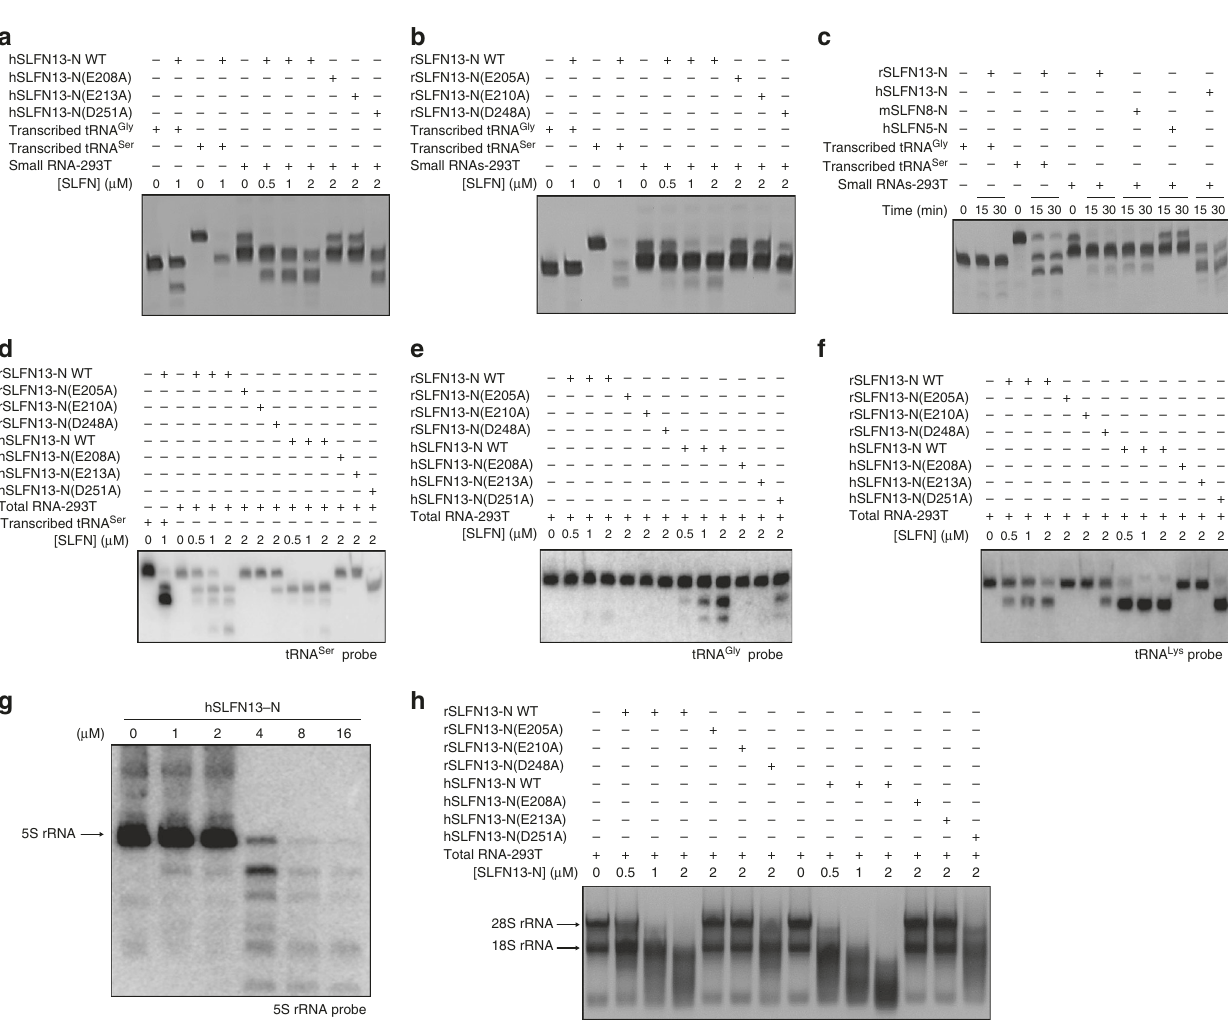
Fig. 4 SLFN13-N cleaves native tRNA and rRNA. a , b Cleavage assay of hSLFN13-N ( a ) and rSLFN13-N ( b ) on native tRNAs in the presence of Mg 2 + . Small RNA-293T denotes total small RNA extracted from 293T cells that is mainly constituted of tRNAs. tRNA Ser and tRNA Gly were used as controls to indicate molecular weight. c Cleavage assay of different SLFN-Ns on native tRNAs. d – f Cleavage assay on speci fi c native tRNAs. The substrates and products were identi fi ed by Northern blot using [ γ - 32 P]-labelled probes targeting tRNA Ser ( d ), tRNA Gly ( e ) or tRNA Lys ( f ). g Cleavage assay for hSLFN13-N on 5S rRNA. 5S rRNA and products were identi fi ed by Northern blot. h Cleavage assay on native rRNAs. 4 μ g total RNA extracted from 293T cells was used for each reaction, which mainly contains